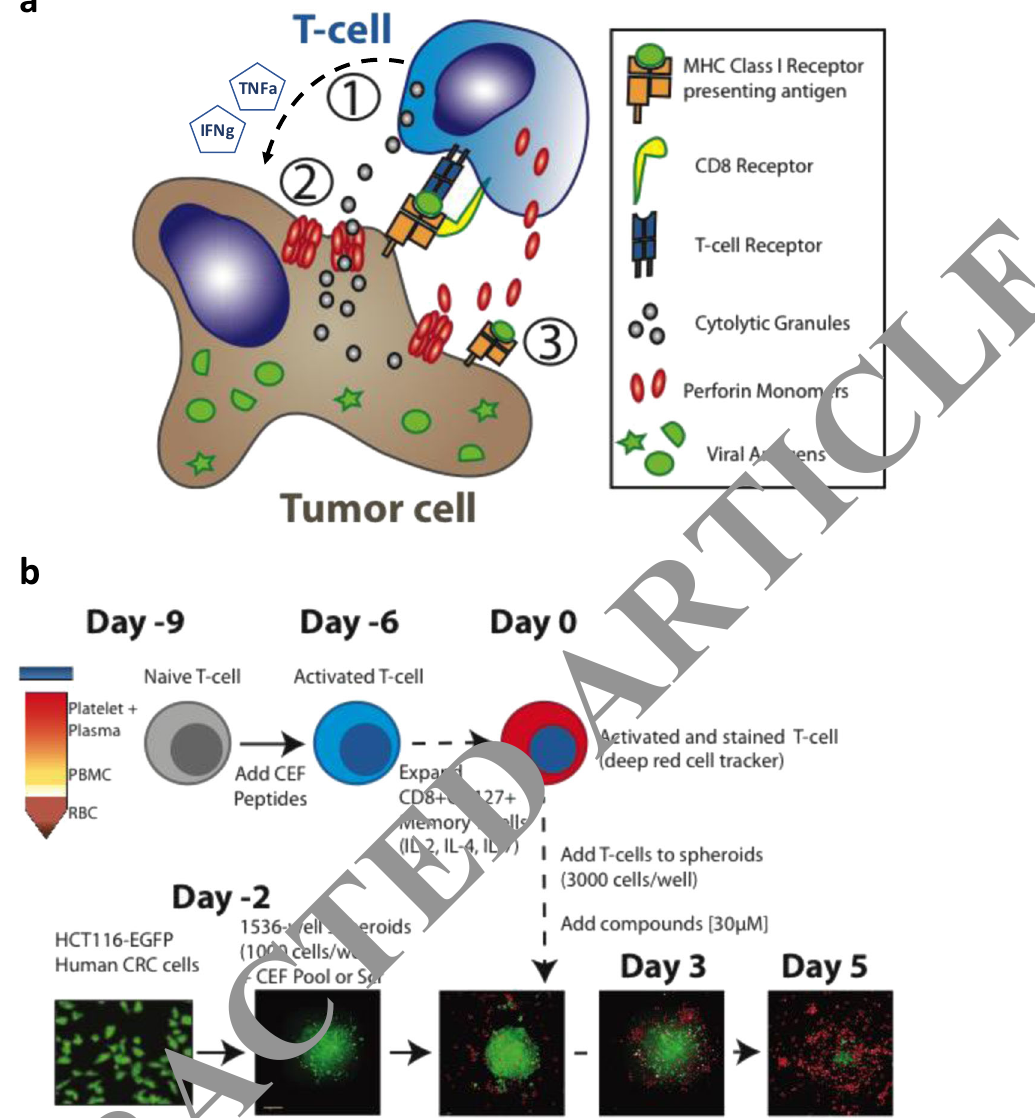
Fig. 1 Cellular model and screening work fl ow of T-cell tumor spheroid-killing platform. a Three different mechanisms by which small molecules might enhance anti-tumor T-cell function: (1) upregulate biosynthesis/secretion of anti-tumor cytokines (e.g., IFNg, TNFa), (2) increase production/secretion of T-cell cytolytic granules or perforin proteins or (3) upregulate antigen processing/presentation on tumor cells. b Work fl ow of IO screening platform. Human HLA-A02 PBMCs are isolated and cultured in the presence of CEF viral peptides (day − 9). Activated T-cells are expanded fi rst in IL-2 (2 days), then in IL-2, IL-4, and IL-7 (4 days) to generate the desired memory T-cell population. Human HCT116-EGFP colorectal cancer cells are dispensed into 1536-well spheroid plates (day − 2) and on day 0 T-cells are stained red and added to spheroid cultures. Experimental compounds are added and co- cultures are incubated for 3 days before the fi rst imaging read and then a further 2 days before the fi nal imaging